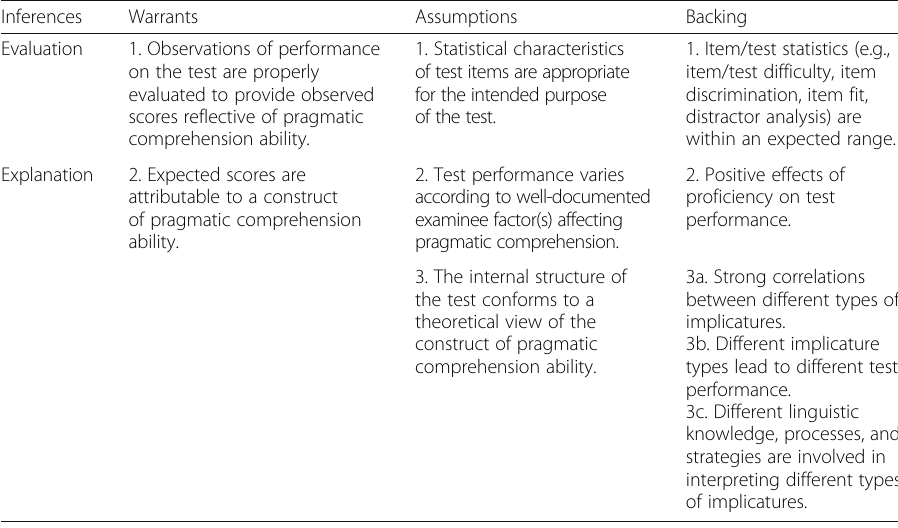
Table 1 An overview of the evaluation and explanation